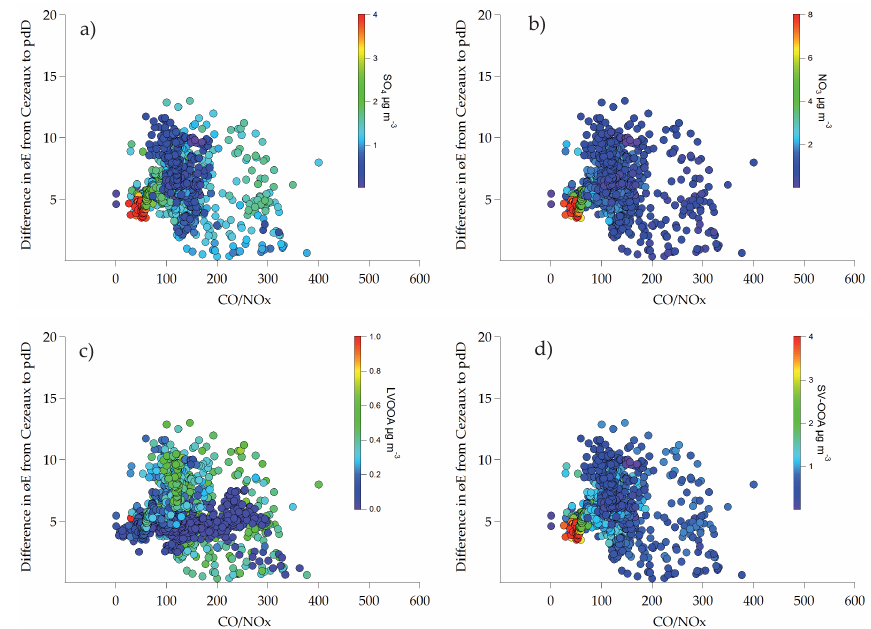
Fig. 7. Difference in θe vs the CO/NO x ratio during winter 2009. Plots are coloured by (a) SO 4 , (b) NO 3 , (c) LV-OOA, and (d)